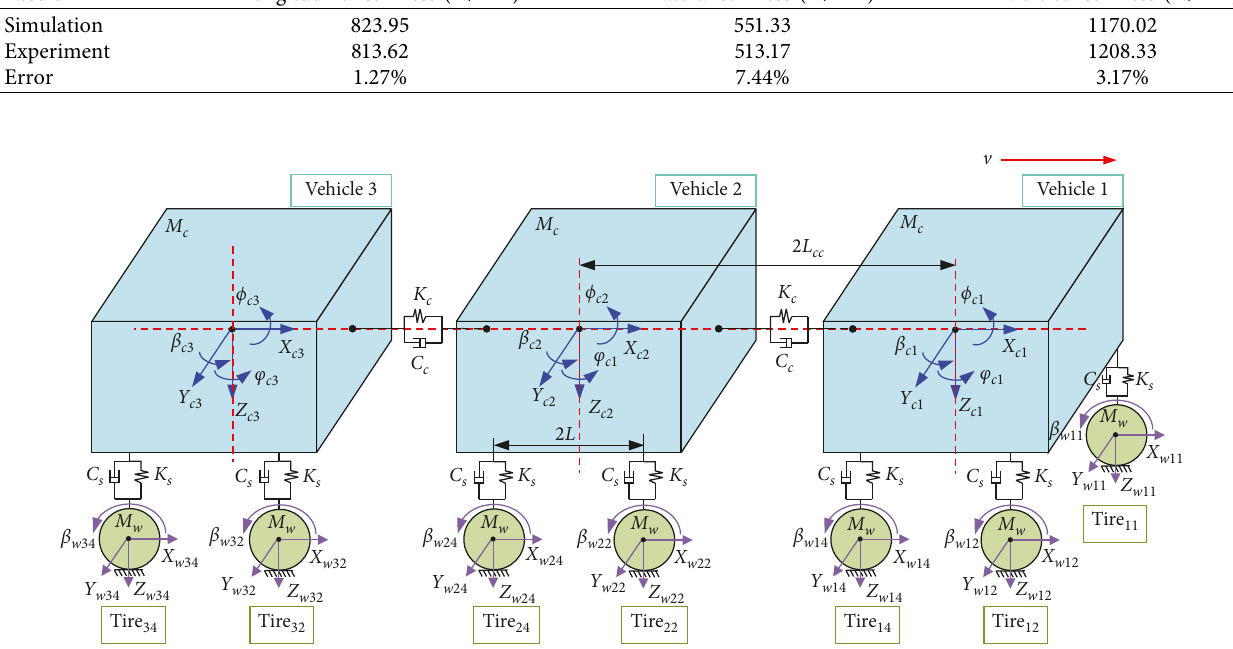
Figure 4: Virtual track train dynamics model [27]. Table 7: Vertical tire load under different running conditions (kN). Table 9: Lateral tire load under different running conditions